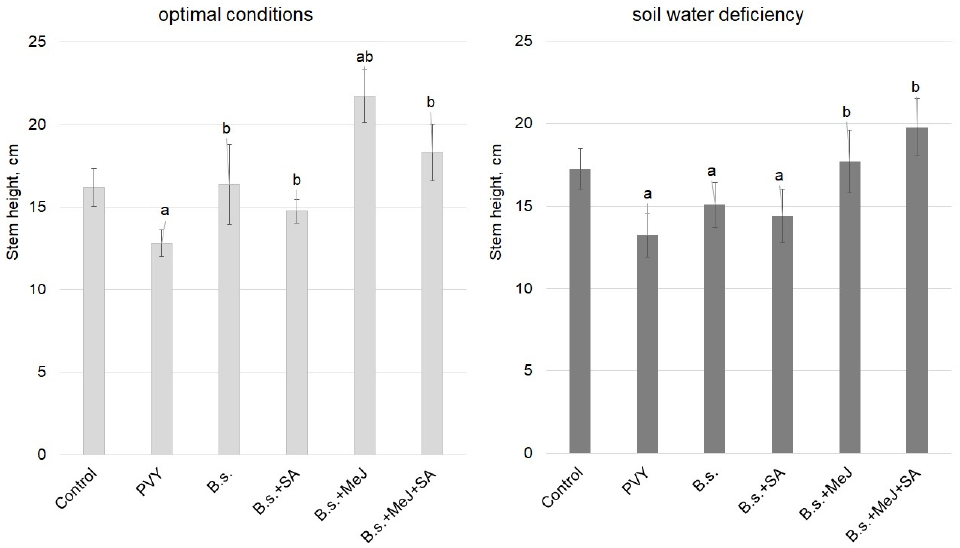
Figure 2. Effect of PVY infection and the mixture of B. subtilis with SA and MeJ application under soil water deficiency on potato stem height. Control—health plants; PVY—infected with PVY plants; B.s.— B. subtilis + PVY; B.s. + SA— B. subtilis + salicylic acid + PVY; B.s. + MeJ— B. subtilis + methyl